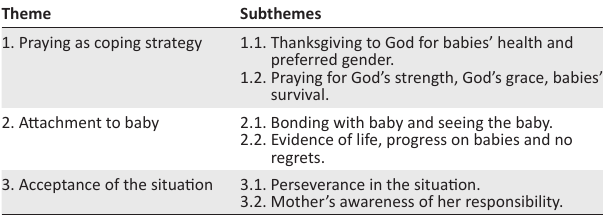
TABLE 1: Themes and subthemes